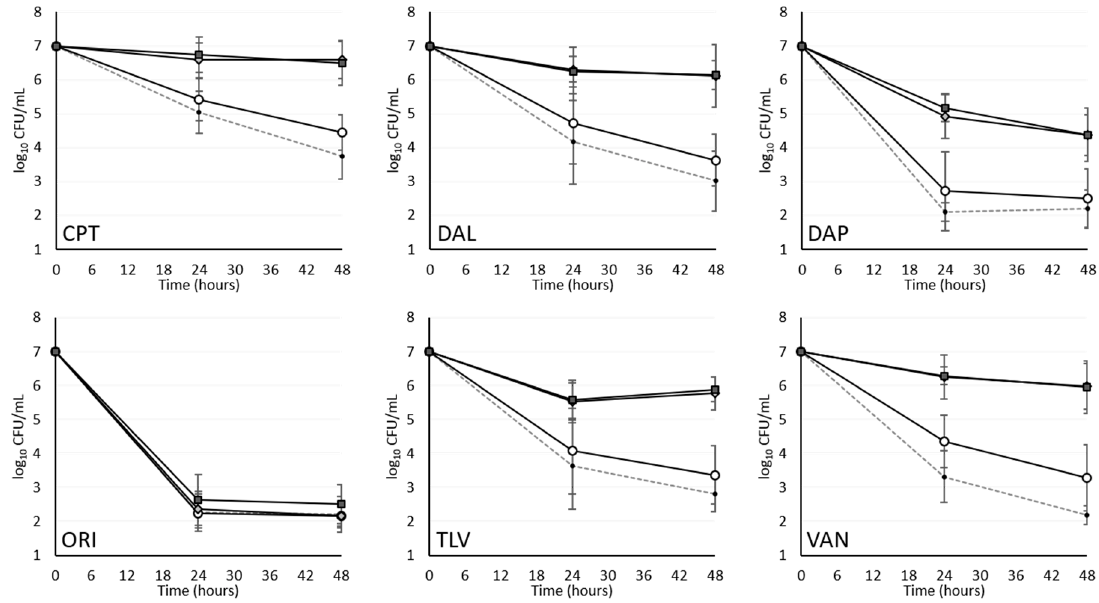
Figure 1. Activity of study antibiotics against mupirocin-induced tolerant staphylococci. Data represent the mean and standard deviation values from five distinct strains, each evaluated in triplicate. Dashed lines, uninduced control; open circles, low mupirocin induction (0.032 µg/mL); gray diamonds, moderate mupirocin induction (0.32 µg/mL); black squares, high mupirocin induction (3.2 µg/mL). Antibiotic abbreviations are as follows: CPT, ceftaroline; DAL, dalbavancin; DAP, daptomycin; ORI, oritavancin; TLV, telavancin; VAN, vancomycin. Uninduced and low-induction exposures were not significantly different at any time point with the exception of CPT and VAN where the two exposures each differed at 48 h ( p < 0.01). Moderate and high mupirocin induction were essentially indistinguishable from each other and significantly different from uninduced strains ( p < 0.01) at all time points and for all exposures with the exception of ORI ( p > 0.05).